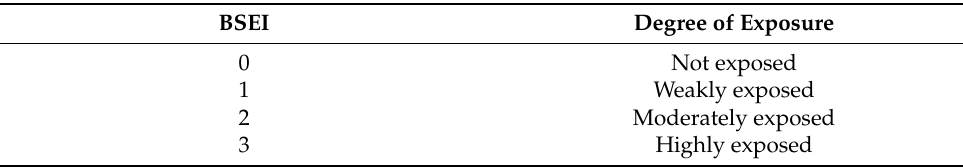
Table 4. Bioclimatic-shift expose index (BSEI) interpretation.